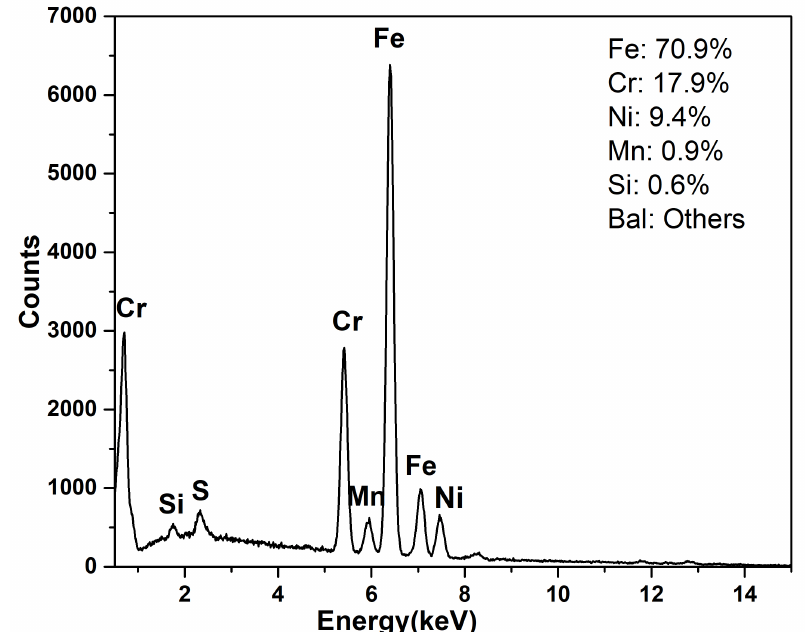
Figure 9. EDS analysis of the 316L SS substrate (See Figure